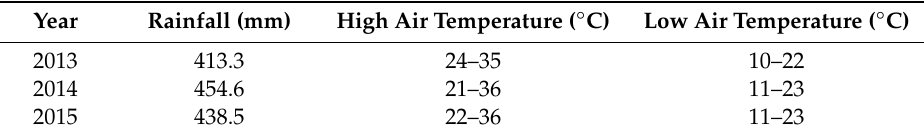
Table 1. Rainfall, high air temperature, and low air temperature during the growth period of maize during the study period.